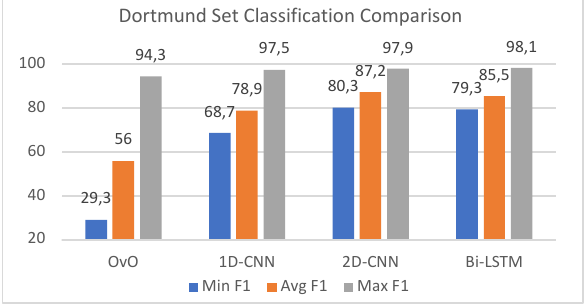
Figure 11. Minimum, average and maximum F1 scores comparisons by algorithm for Dortmund